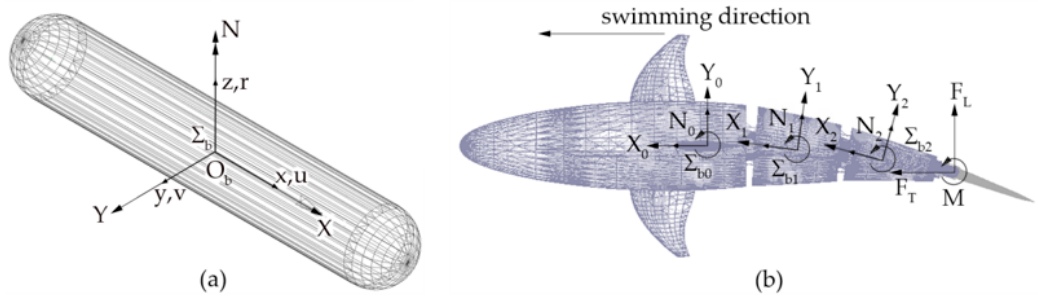
Figure 9. ( a ) Cylindrical body: hydrodynamic loads and body-frame convention [19]. ( b ) Robotic fish: hydrodynamic loads and propulsive forces. Table 1. Added mass and damping coe ffi cient for a cylinder with a radius R , length L , and mass m [17]. X . u